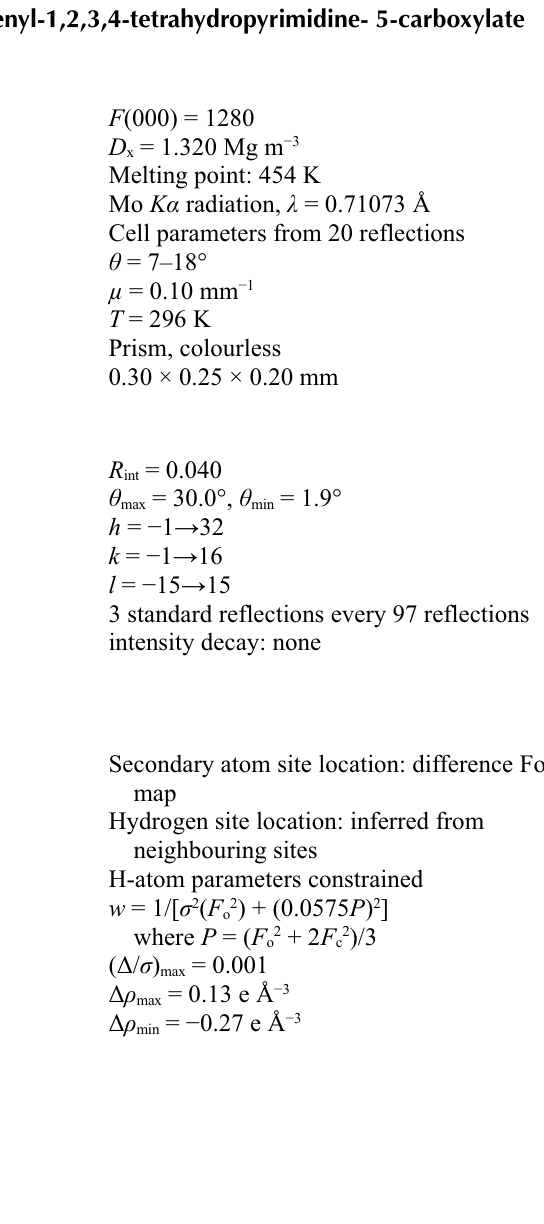
Figure 2 The structures of (1), (2) and (3). Methyl 6-methoxycarbonylmethyl-2-oxo-4-phenyl-1,2,3,4-tetrahydropyrimidine-